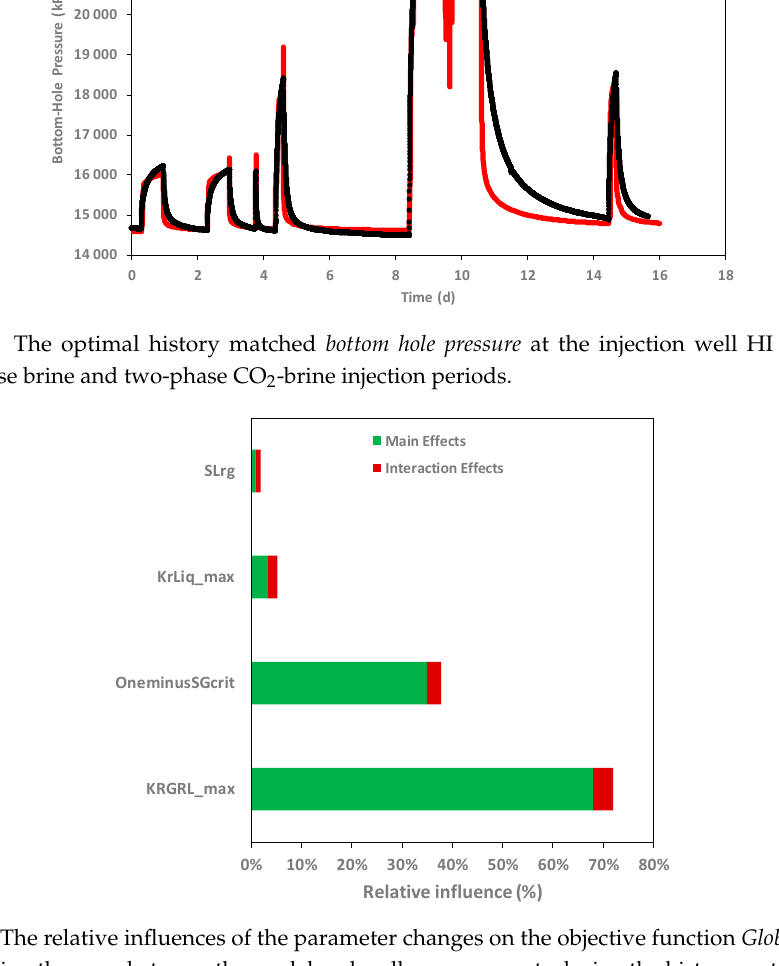
Figure 11. The relative influences of the parameter changes on the objective function GlobalHMError , characterizing the error between the model and well measurements during the history matching of the CO 2 and brine injections. The main and interaction effects are, respectively, the linear and quadratic influences of the parameter changes on the objective function.